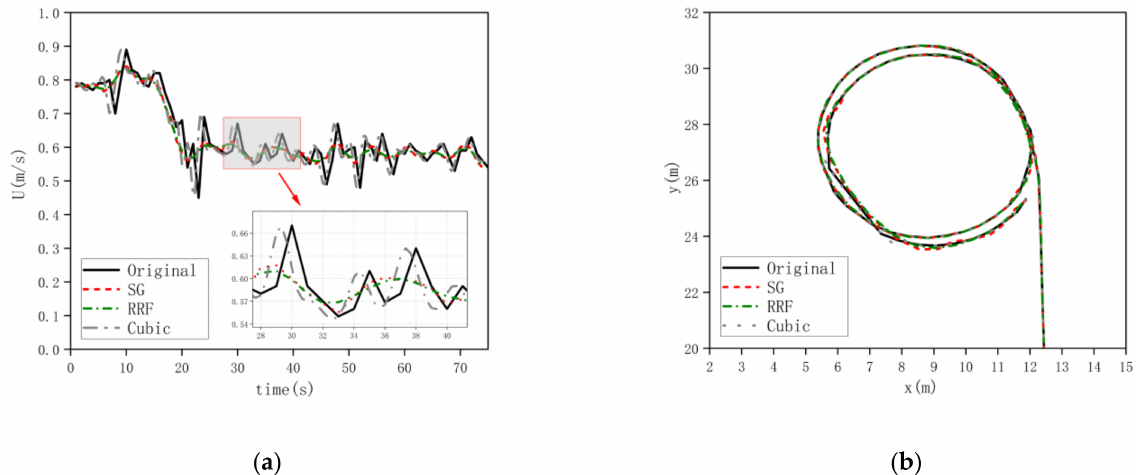
Figure 9. Comparison results of different data processing methods ( a ) Comparison results of the resultant speed. ( b ) Comparison results of the